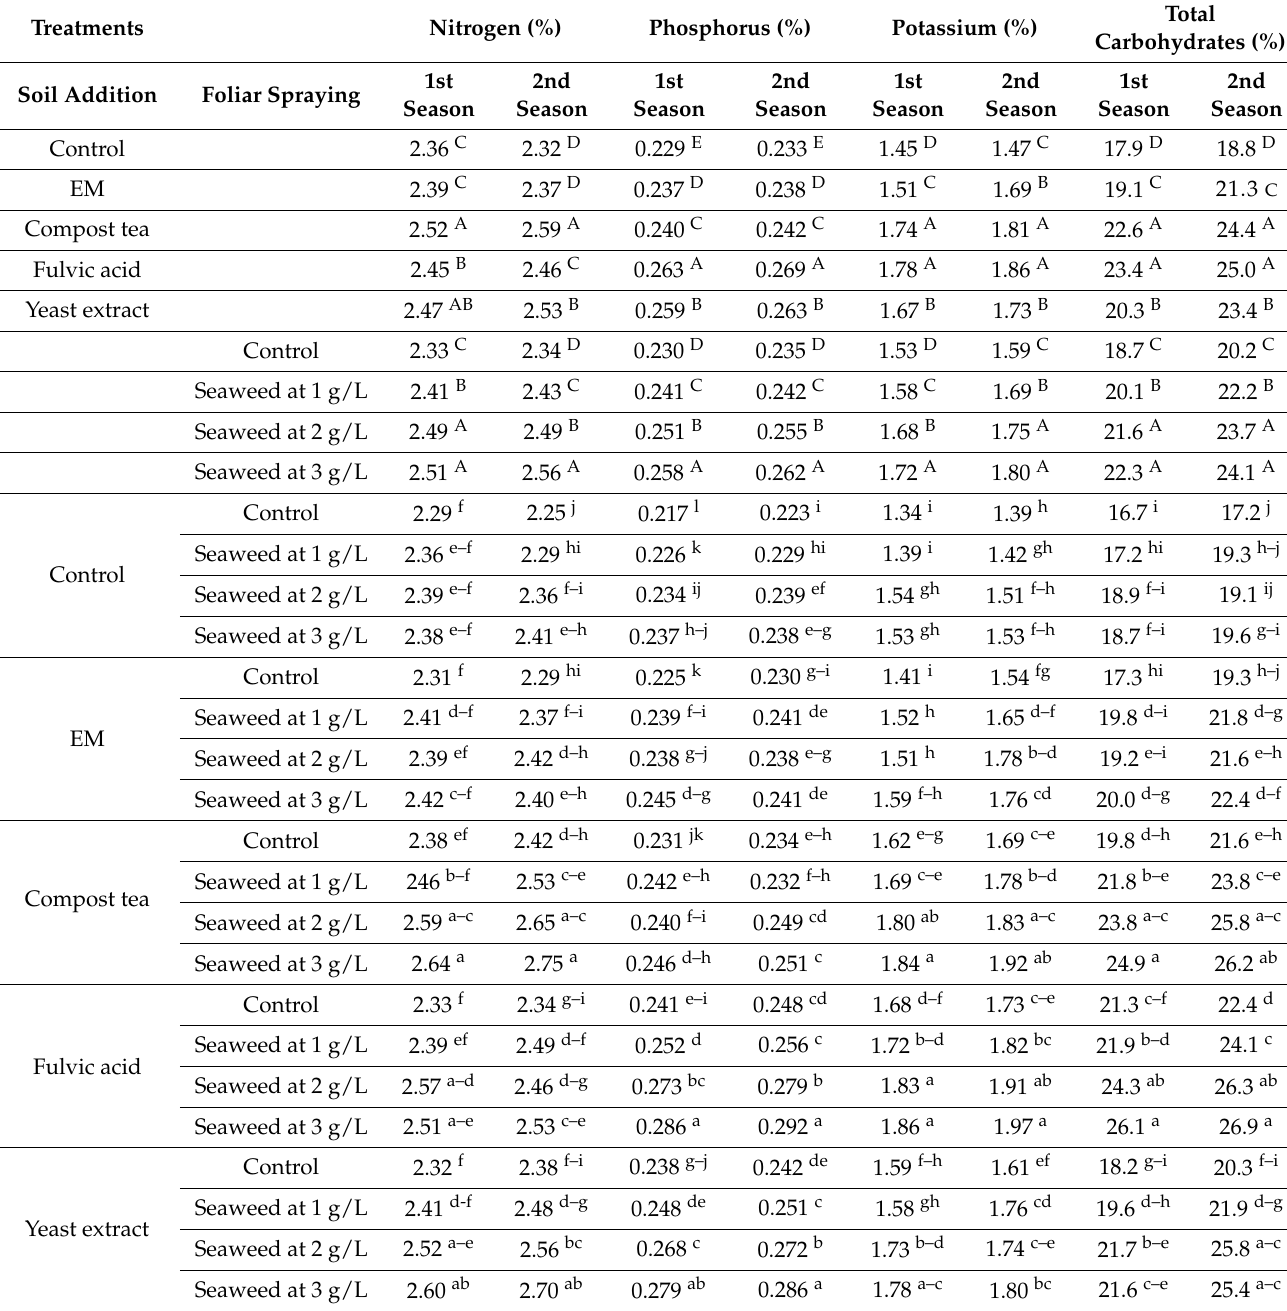
Table 2. Effects of soil addition of EM, compost tea, fulvic acid, yeast extract, and foliar spray with seaweed extract and their combinations on the chemicalconstituents of the plant foliage of sweet pepper plants during the 2019/2020 and 2020/2021